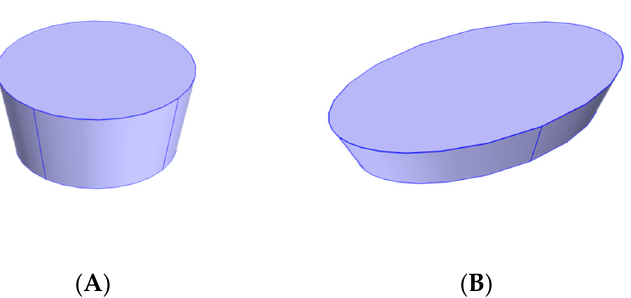
Figure 5. Geometry for different shaped samples for thickness optimization ( A ) conical frustum- shaped sample; ( B ) elliptical frustum-shaped sample.